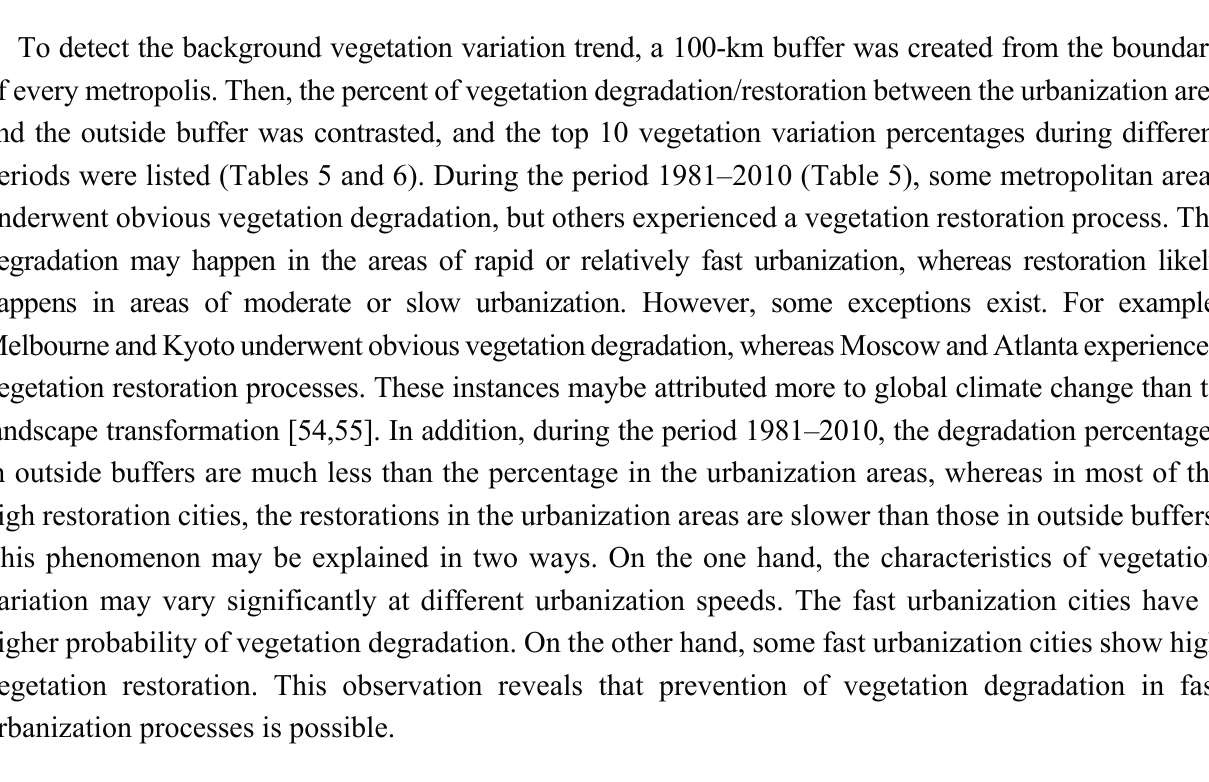
Table 5. The top 10 cities with the highest variation percentages in the urbanization area and the comparison with outside buffers from 1981 to